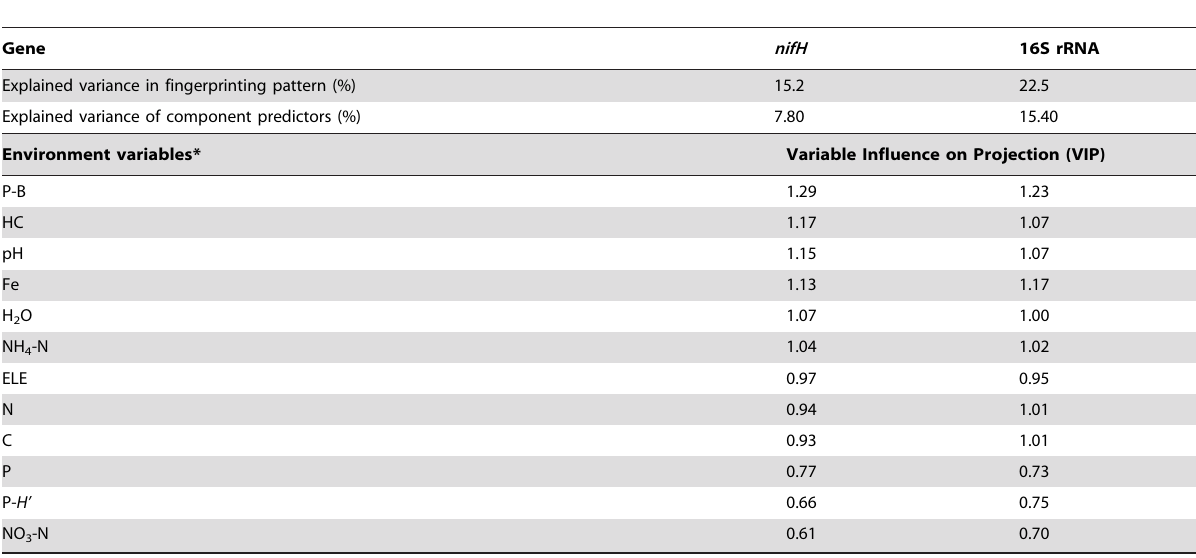
Table 2. Results of partial least squares regression (PLSR) analysis with the explanatory capacity of the first component and the variable influence on projection (VIP) of each predictor within each component to estimate significant